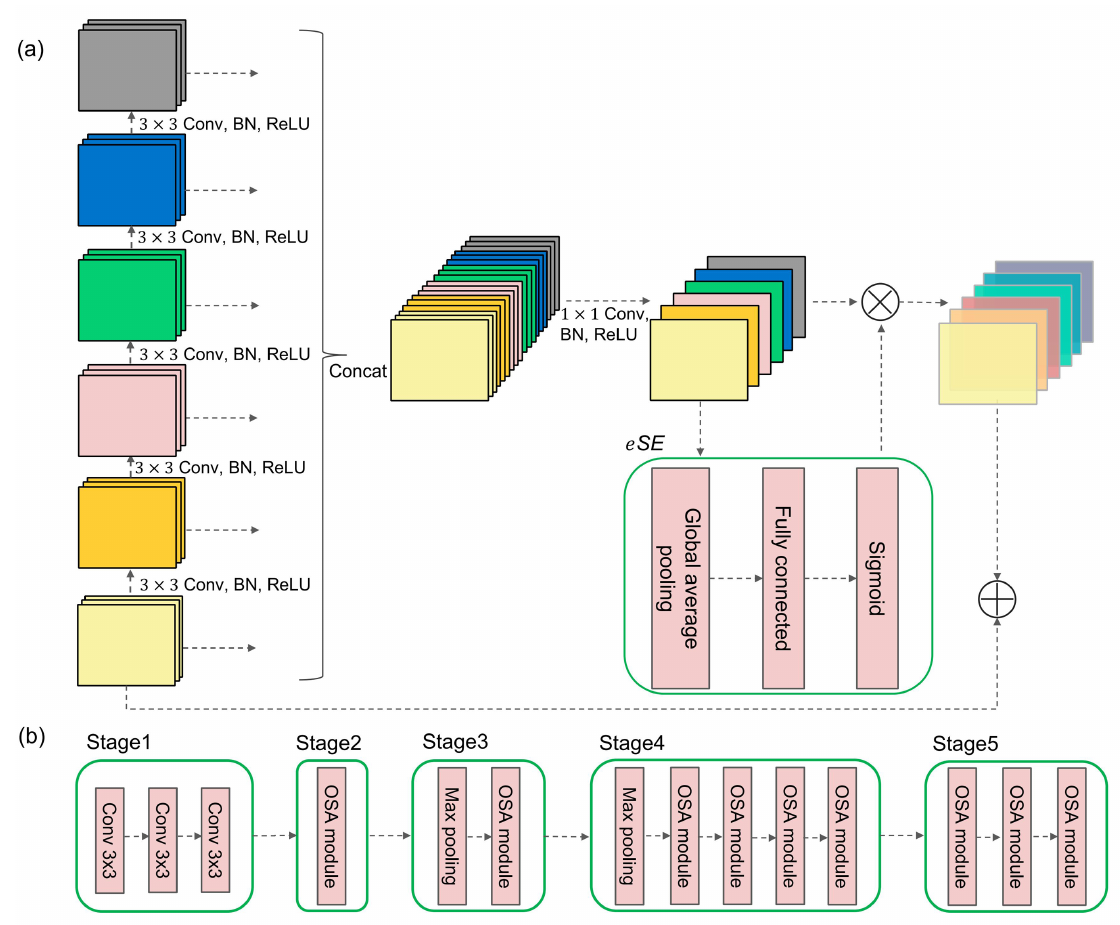
Figure 3. Structure of VoVNet-v2. ( a ) Structure of OSA module; ( b ) specific operation process of